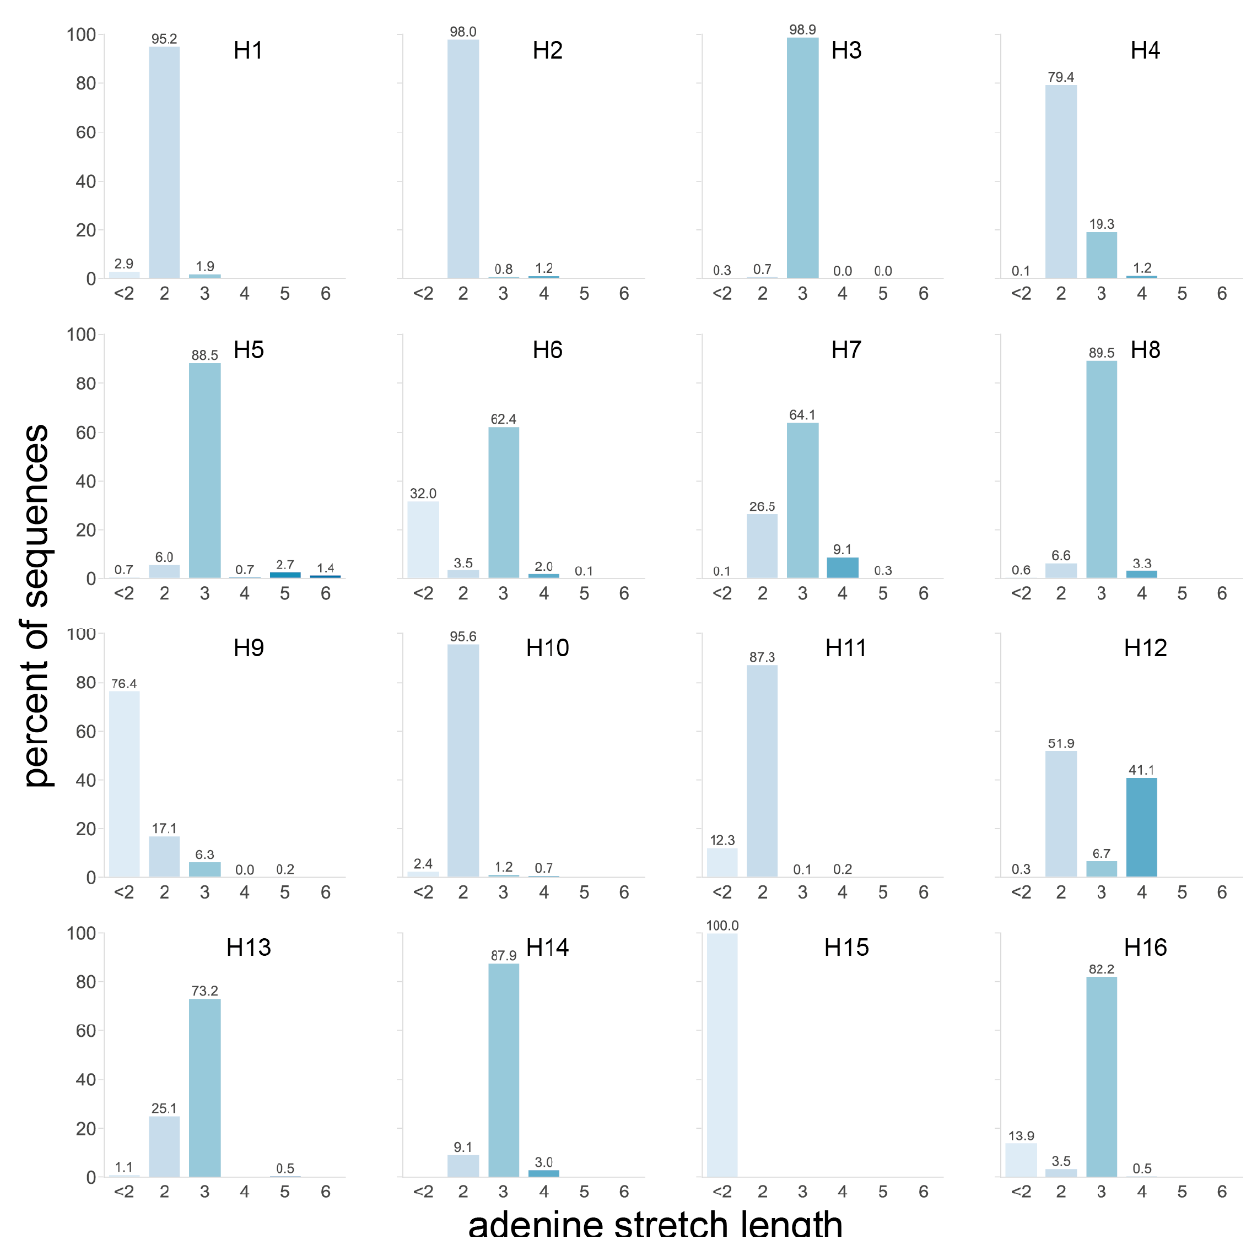
Figure 5. Length of the longest adenine stretch in the P4 to P1 HA cleavage site region for each subtype. The longest stretch of adenines in the 4 codons preceding the HA cleavage site was identified in each sequence, and the percentage of sequences with a given stretch length was calculated independently for each subtype. A darker shade of blue indicates a longer stretch, and the exact percentages are given above each bar.